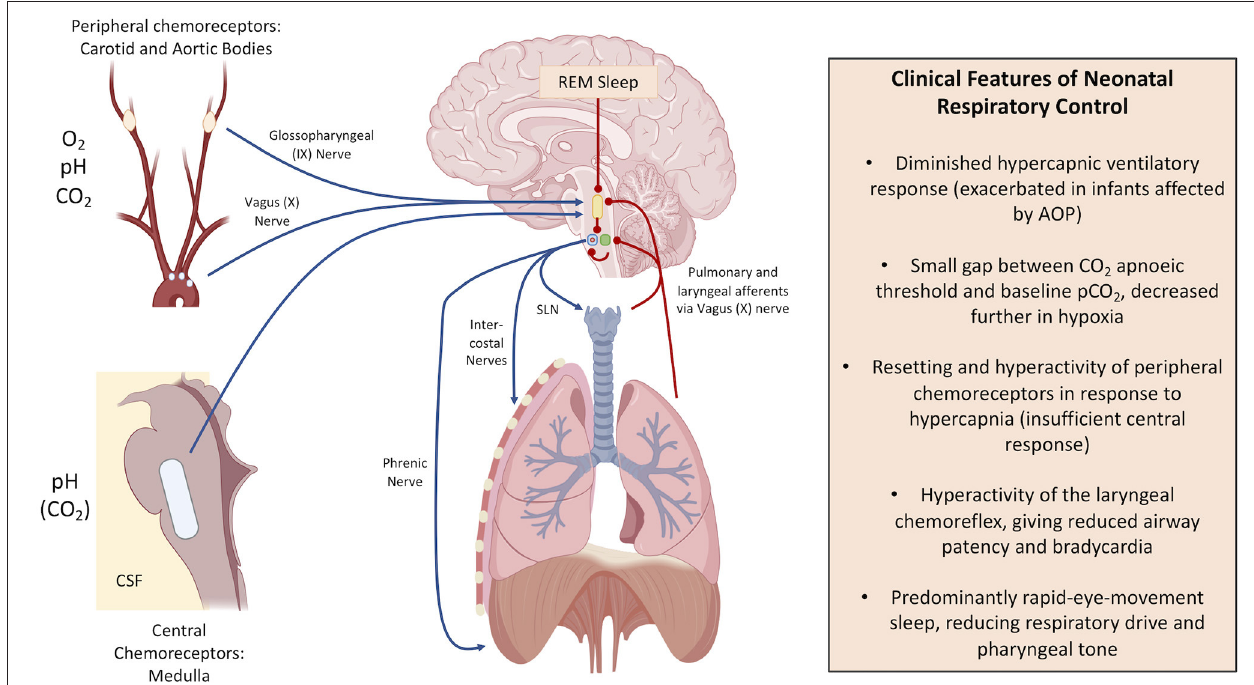
FIGURE 1 | Respiratory control mechanisms and the differences in infancy. Blue arrow: positive stimulation (encourages ventilation). Red lines: negative stimulation (depresses ventilation). In the brain: the yellow shape indicates pontine respiratory centre, the green circle indicates the dorsal respiratory group, the blue circle indicates the ventral respiratory group, and the red dot illustrates the pre-Bötzinger Complex. SLN is the Superior Laryngeal Nerve. This figure was created using BioRender